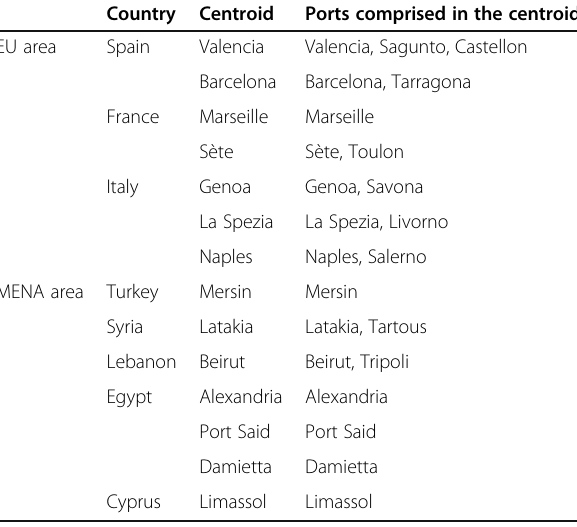
Ports comprised in the centroid